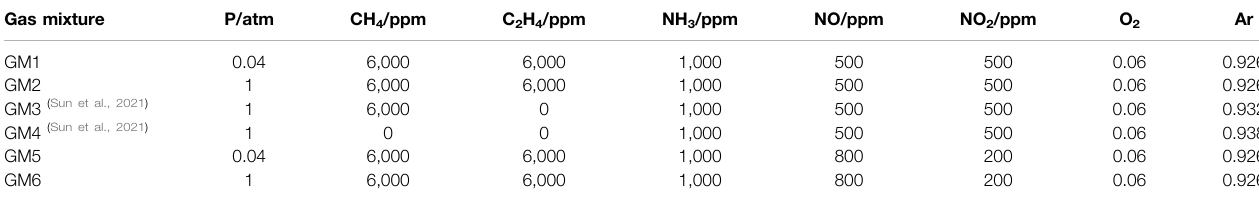
TABLE 1 | Experimental